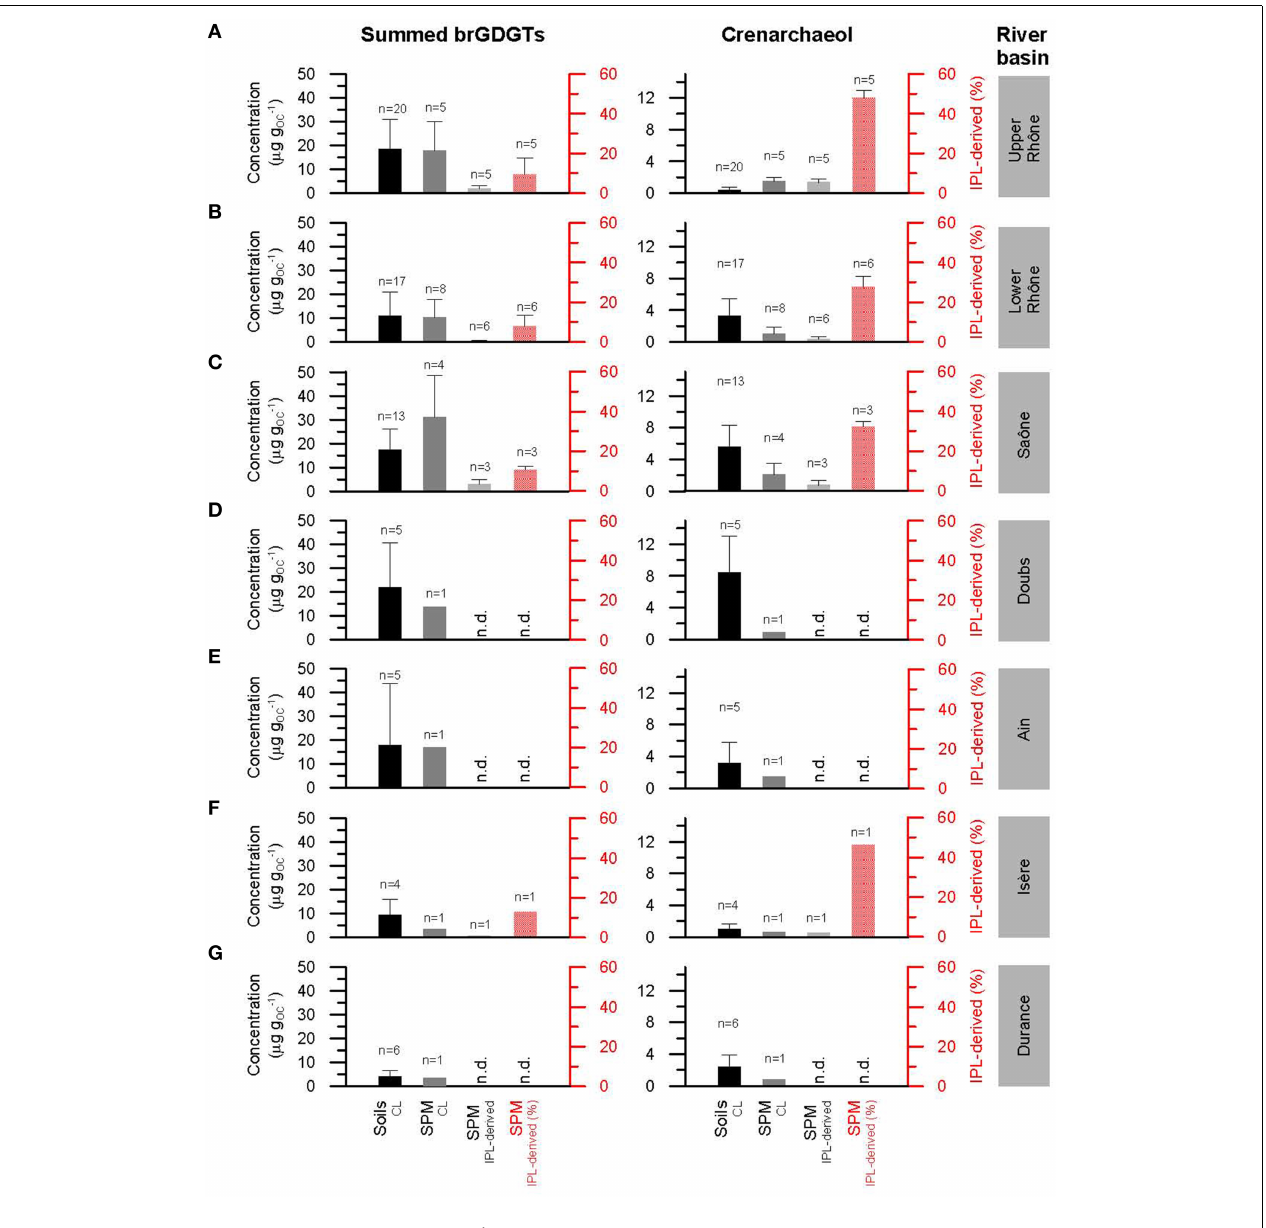
FIGURE 4 | Histograms of the concentration ( µ g g OC − 1 ) of summed CL and IPL-derived brGDGTs (the sum of all the brGDGTs) and crenarchaeol normalized to OC and the IPL-derived fractions (%) from soils and SPM collected in the